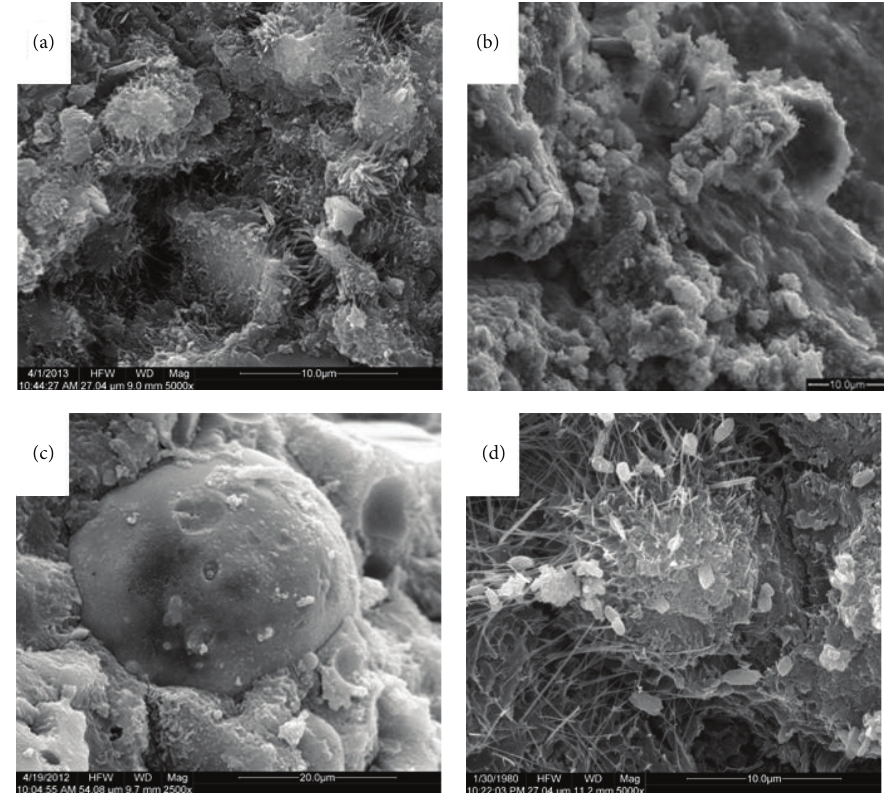
Figure 11: Microstructure of hydration products of (a) C, (b) L2, (c) R2, and (d) G2 at 28